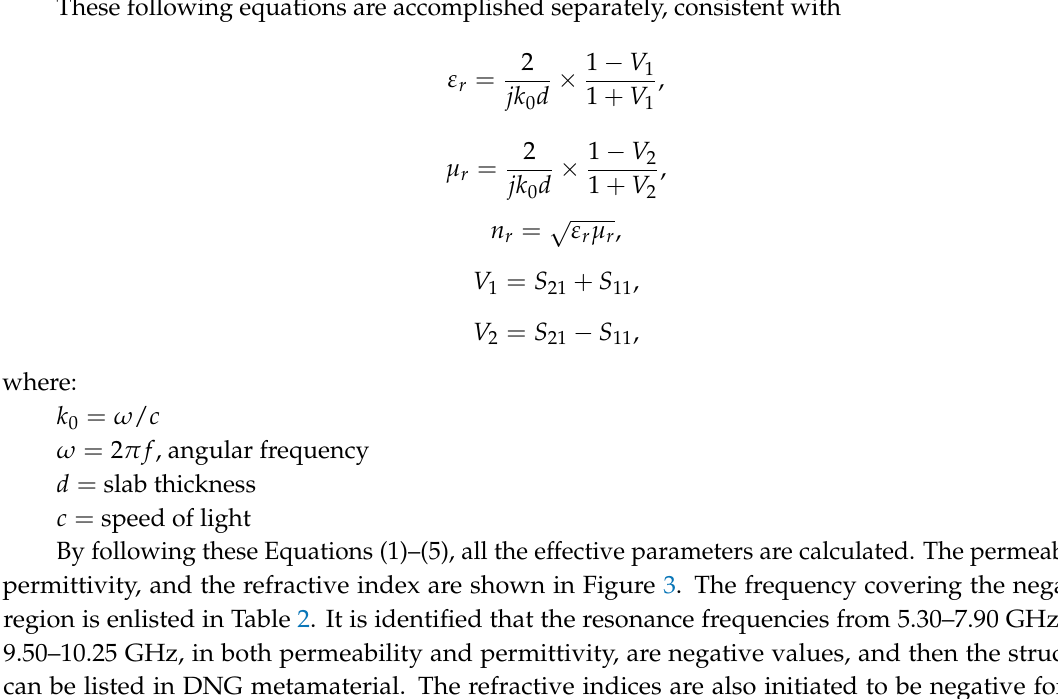
Figure 2. The magnitude of S-parameters ( S 11 and S 21 ) for the reported unit cell (Figure 1).